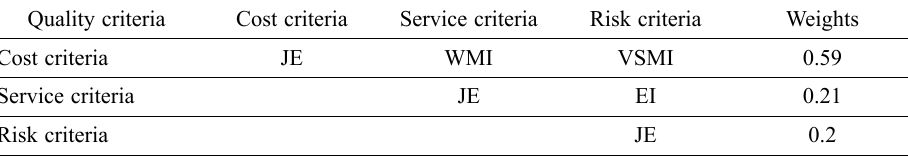
Table 9. Inner-dependency matrix of the criteria with respect to “quality”